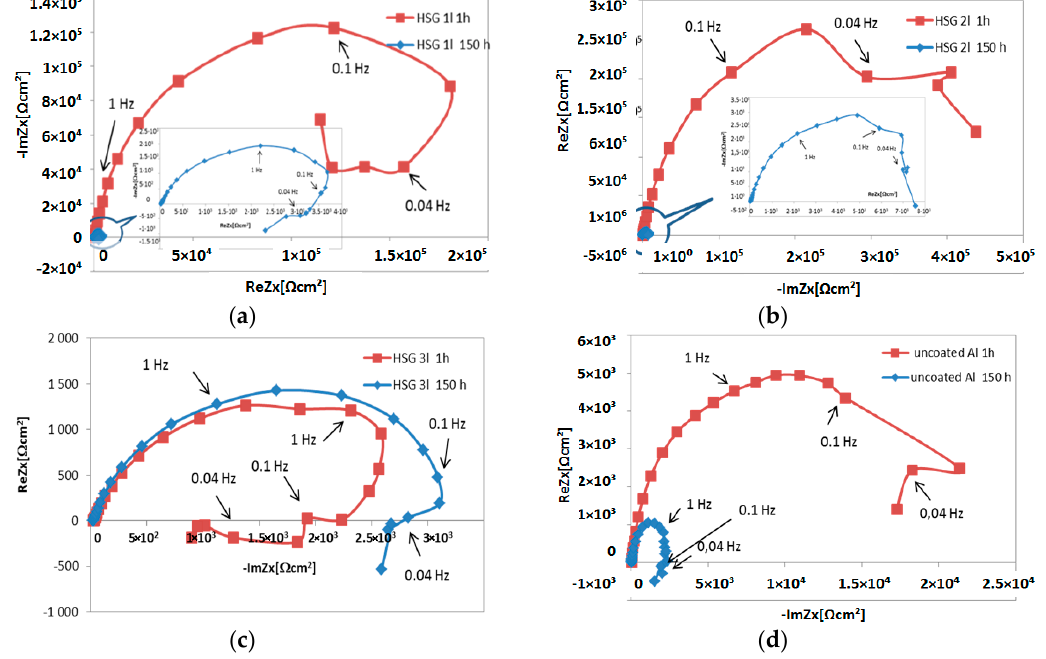
Figure 7. Nyquist plots of HSG coatings and uncoated aluminum after 1h and 150 h of soaking: ( a ) single-layer coating, ( b ) double-layer coating, ( c ) triple-layer coating, and ( d ) uncoated aluminum